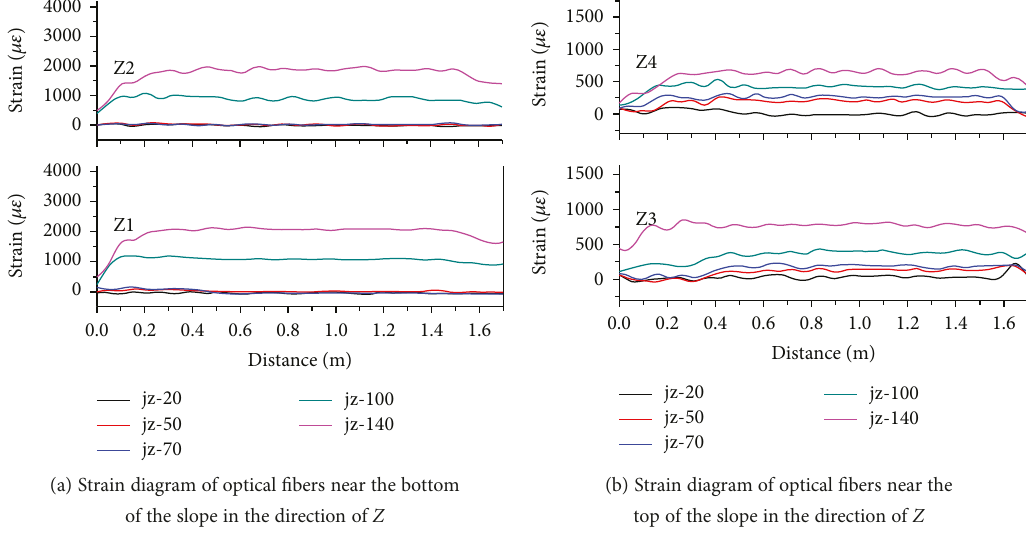
Figure 10: Strain diagram of optical fi bers in the Z direction under di ff erent loading